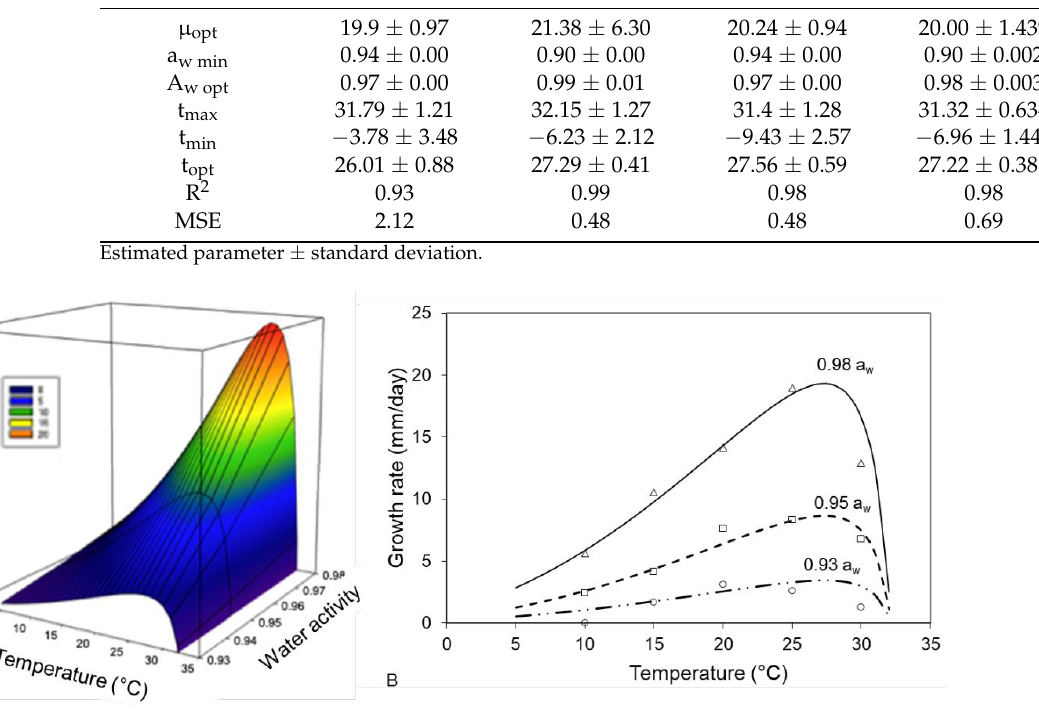
Figure 4. Estimated probability of growth of F. asiaticum (strain 082) under different interacting environmental conditions on a wheat-based media after 3, 5 and 10 days. 3.2. Ecophysiological Study of Mycotoxin Production 3.2.1. Mycotoxin Production The accumulated type B trichothecenes and ZEA after 10 days growth of the strains of F. asiaticum was quantified (Figure 5). This showed that all the strains produced more than one mycotoxin, although 15-AcDON was only produced by F. asiaticum strain Ch024b at 0.98 aw and both 25 and 30 °C (data not shown). In contrast to growth, significant differences were found between strains ( p < 0.05) in terms of mycotoxin production. Overall, DON and ZEA were produced in higher amounts and over broader